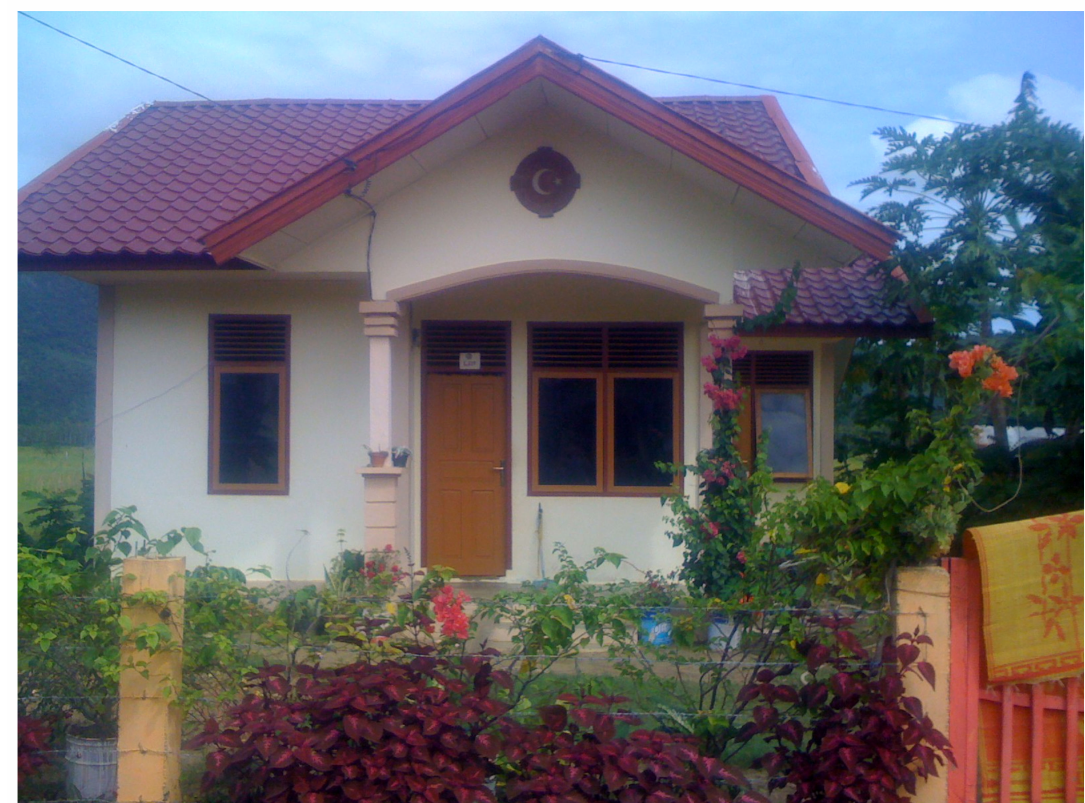
Figure 1. Tsunami assistance house (author’s